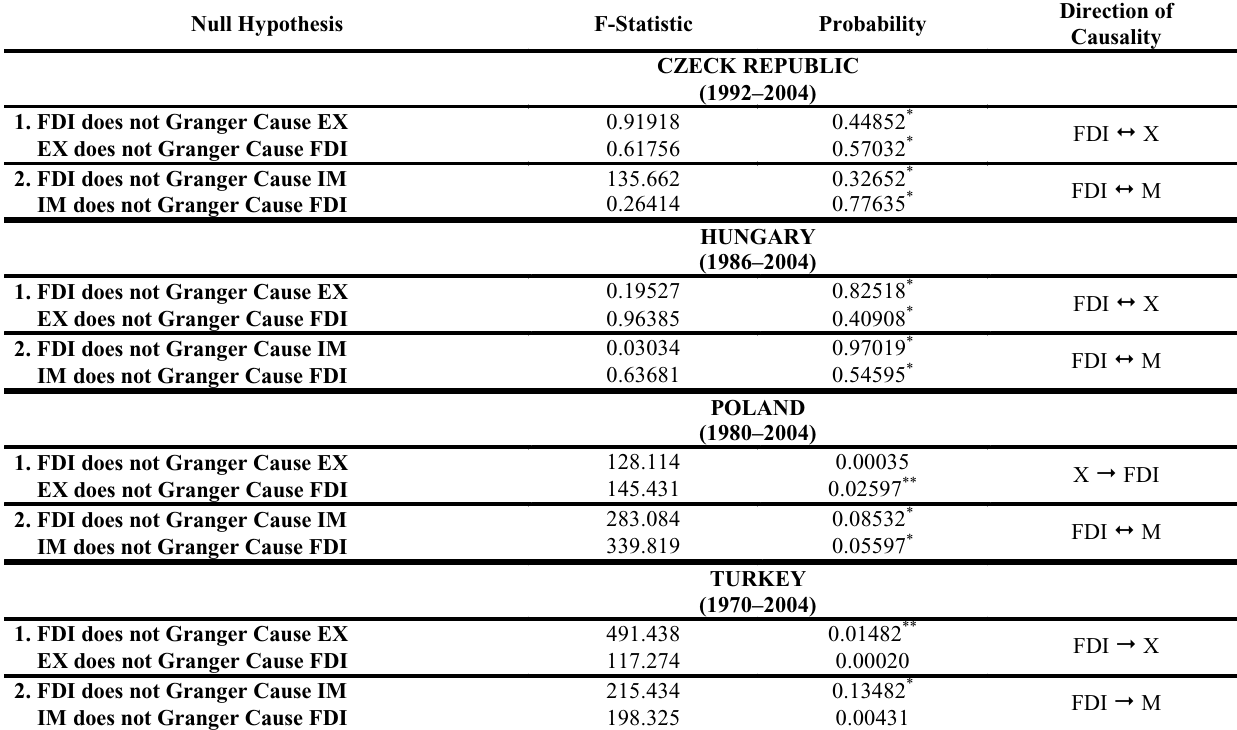
Table 12. Granger Causality Tests for FDI, Exports and